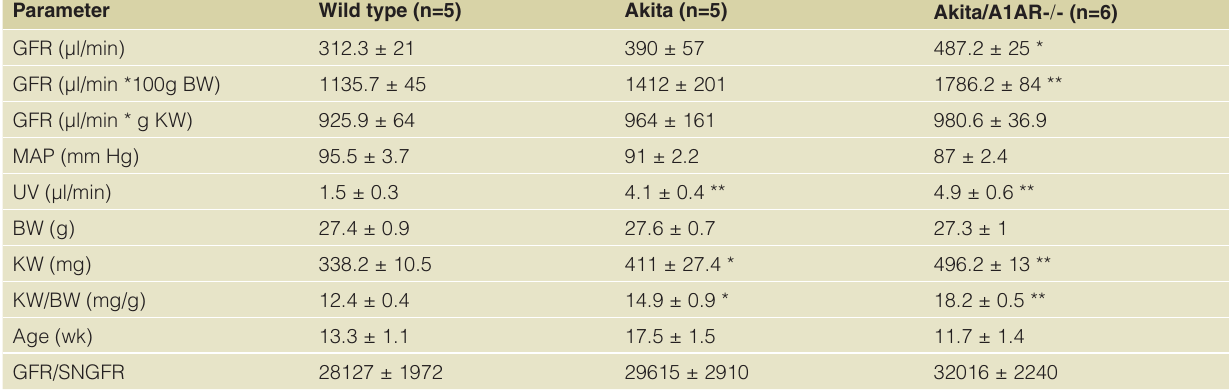
Table 1. Kidney function and general metrics of wild type (WT), Akita, and Akita/A1AR - / - double mutant mice.